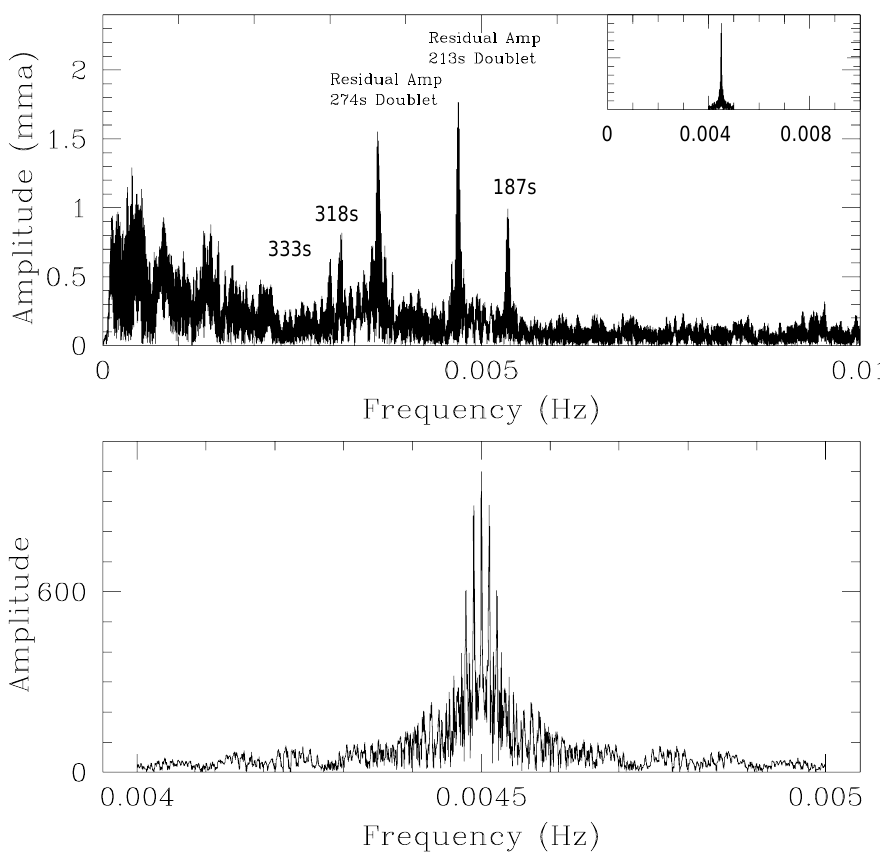
Fig. 6. Pre-whitened FT of the 1991 data set, clearly showing the additional modes 187 s, 318 s and 333 s in the top panel. The doublets did not get pre-whitened completely and some residual amplitude is left behind. The lower panel indicates the window